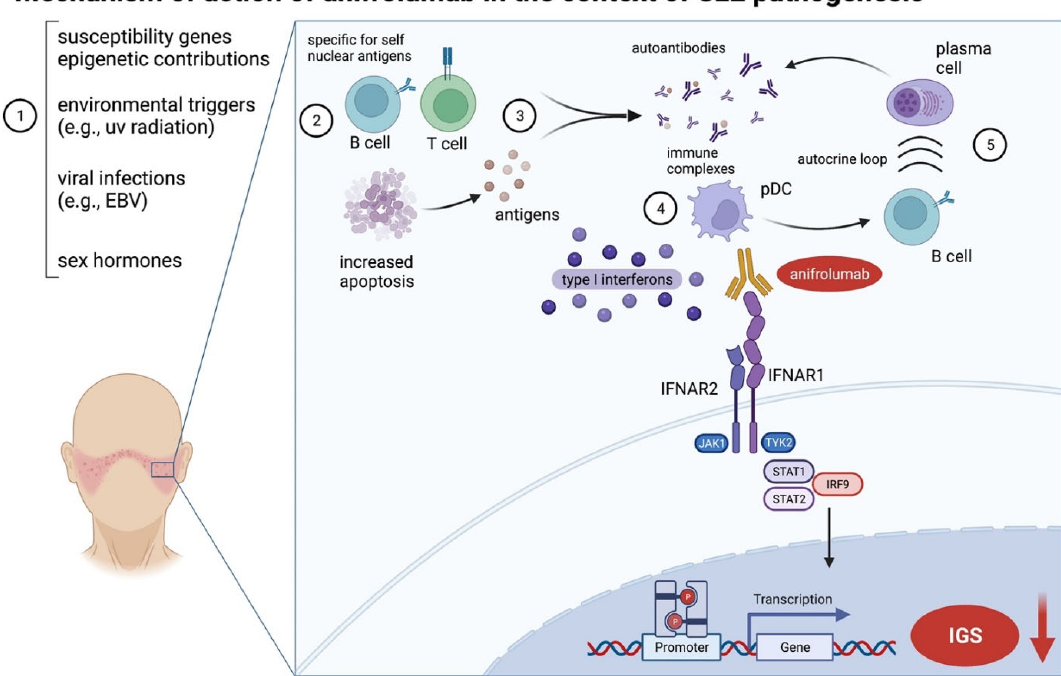
Figure 3. Mechanism of action of anifrolumab in the context of the hypothesized systemic lupus erythematosus (SLE) pathogenesis [3,4,6]. Genetic, epigenetic, environmental, and hormonal factors (1) lead to an increased rate of apoptosis. Autoreactive B and T cells specific for self ‐ nuclear antigens recognize and process these antigens (2), which, in turn, leads to autoantibody and immune complex generation (3). Toll ‐ like receptor signaling in B cells and pDCs (not shown) results in increased levels of type 1 interferons, mainly produced by pDCs (4). Type 1 interferons further stimulate B cells in an autocrine loop, and B cells exhibit class switching, which leads to a persistent production of autoantibodies (5). Anifrolumab binds to IFNAR1, thus inhibiting dimerization and subsequent intracellular signaling mechanisms mediated by STAT1/2 and IRF9. The net result is a decreased transcription of proinflammatory genes (the so ‐ called interferon ‐ gene signature, IGS) in cells of both the innate and adaptive immune systems [10]. Created with biorender.com. EBV, Ebstein–Barr virus; IFNAR, interferon receptor subunit; IGS, interferon gene signature; IRF9, interferon regulatory factor 9; JAK, Janus kinase; pDC, plasmacytoid dendritic cells; STAT, signal transducers and activators of transcription; TYK, tyrosine kinase; UV, ultraviolet.